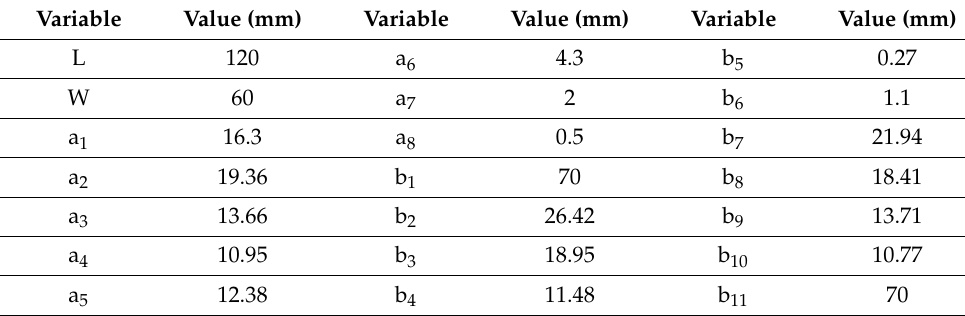
Figure 2. Fabricated antenna: ( a ) Top view, ( b ) bottom view. Table 1. Various antenna